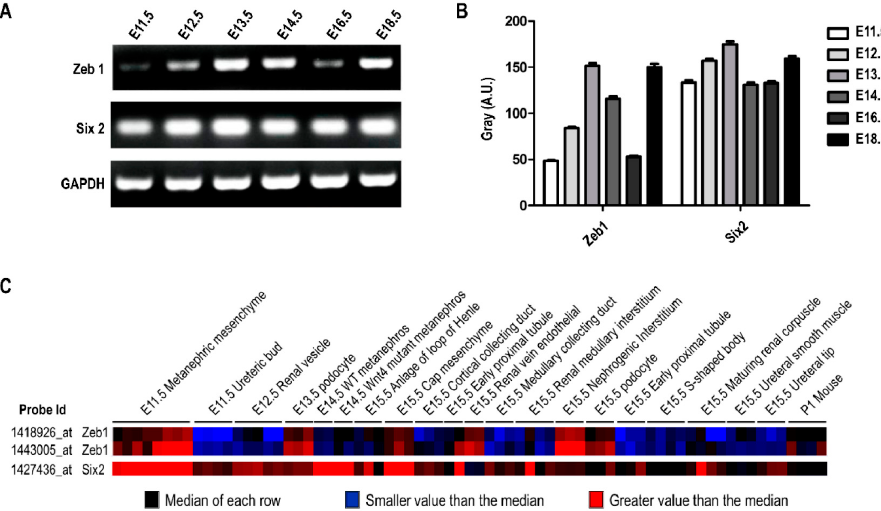
Figure 8. Zeb1 and Six2 have a similar expression profile in mouse kidney development. ( A ) RT-PCR was performed using the cDNA library obtained from the embryonic mouse kidney at different embryonic days (E11.5, E12.5, E13.5, E14.5, E16.5, E18.5). The mRNA expression of both genes showed identical variation trends except for E16.5; ( B ) The quantification was analyzed by Gray Scan normalized to the internal control GAPDH and the results were acted as mean ± SD ( n = 3); ( C ) Bioinformatics analysis of Zeb1 and Six2 mRNA expression was performed in GUDMAP Expression Database. It is the microarray data in different cells of developing renal, in which blue represents the median of each row, black means the expression value is smaller than median, while red represents a larger value.